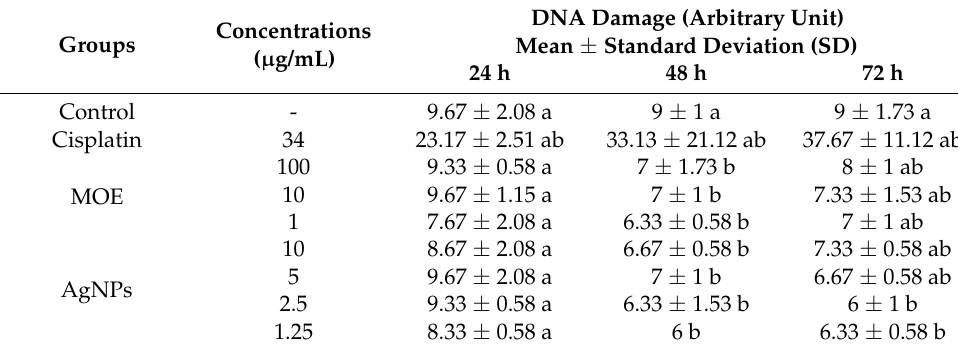
Table 2. DNA damage at different concentrations of M. oleifera extracts (MOE) and biosynthesized AgNPs in HUVEC cell